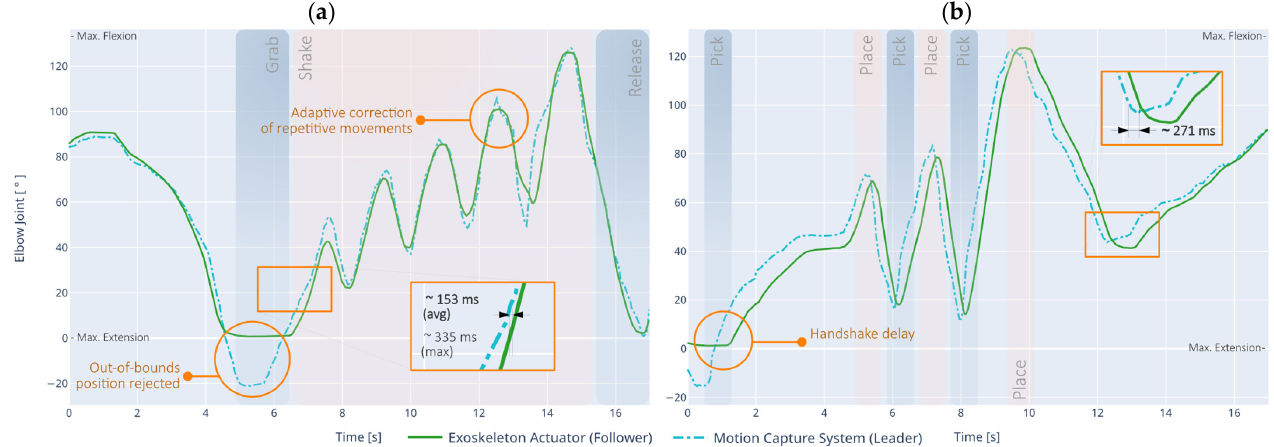
Figure 13. Leader-Follower Mode Controller (LFMC) test using an external motion capture system that is ( a ) connected locally in the healthy limb of the patient, and ( b ) connected via the Internet on the arm of a second person.